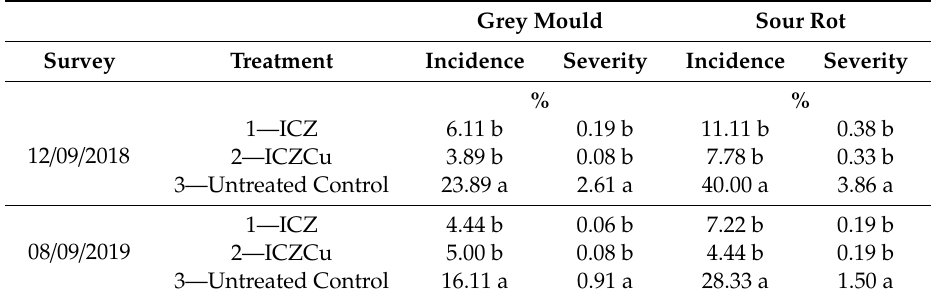
Table 3. Activity of Italian chabasite-rich zeolitite and Italian copper chabasite-rich zeolitite (ICZ and